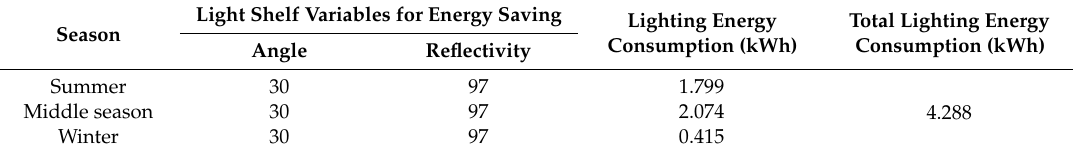
Table 10. Light shelf angle for lighting energy saving and total lighting energy consumption for Case